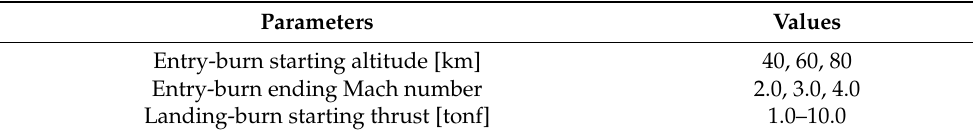
Table 1. Parameters for controlling the re-entry condition.